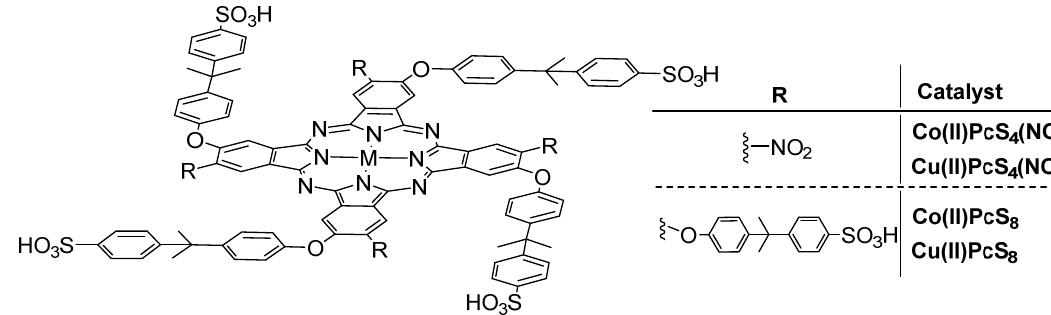
Figure 13. Structures of Co(II) and Cu(II) complexes of tetrasubstituted phthalocyanines bearing nitro and sulfonic acid groups (adapted from [62]).